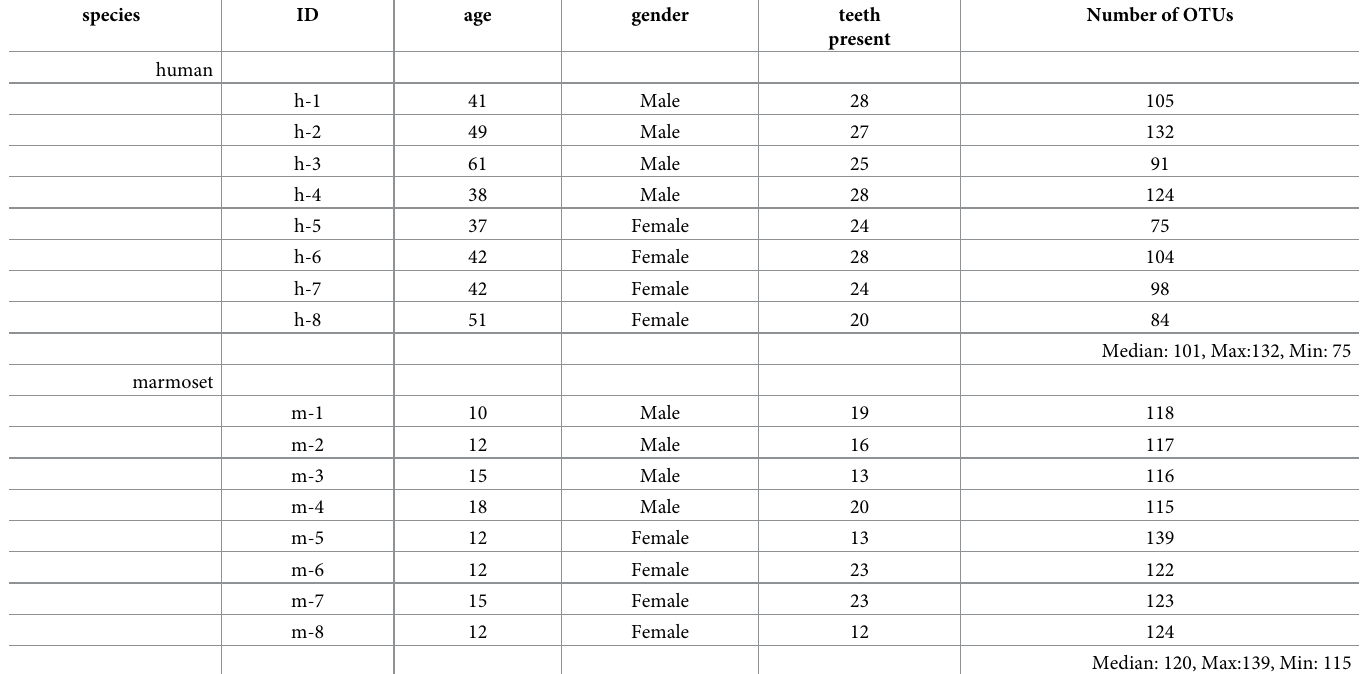
Table 1. List of subjects and their